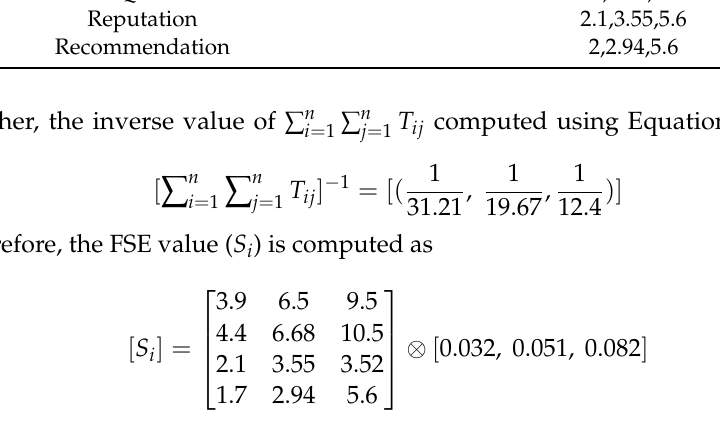
T ij value for each metric. j = 1 Trust Metrics